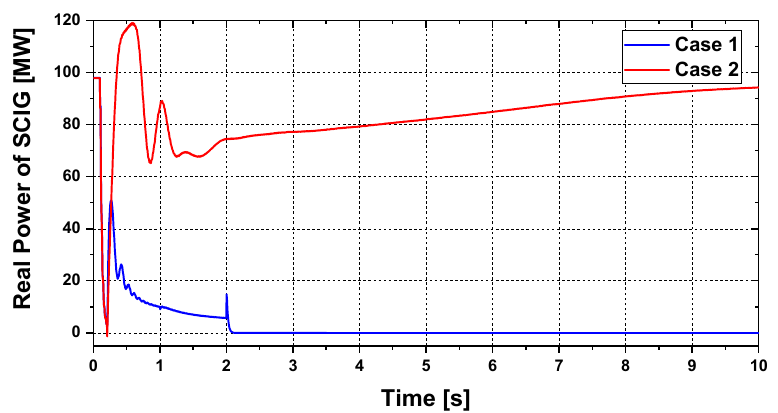
Figure 15. Real power response of SCIG.